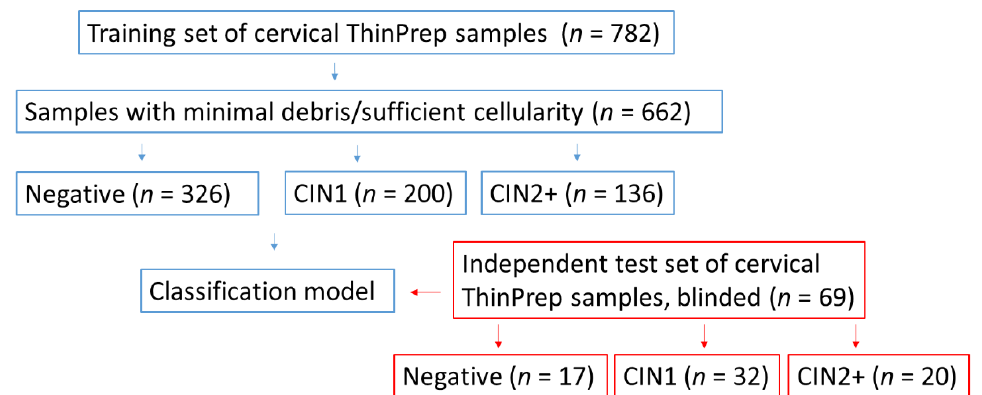
Figure 1. Schematic showing an overview of the training set and the independent test set of cervical ThinPrep samples.